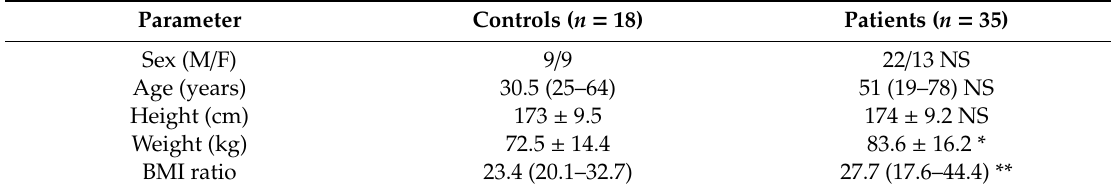
Table 1. Basal characteristic of control group and patients group.